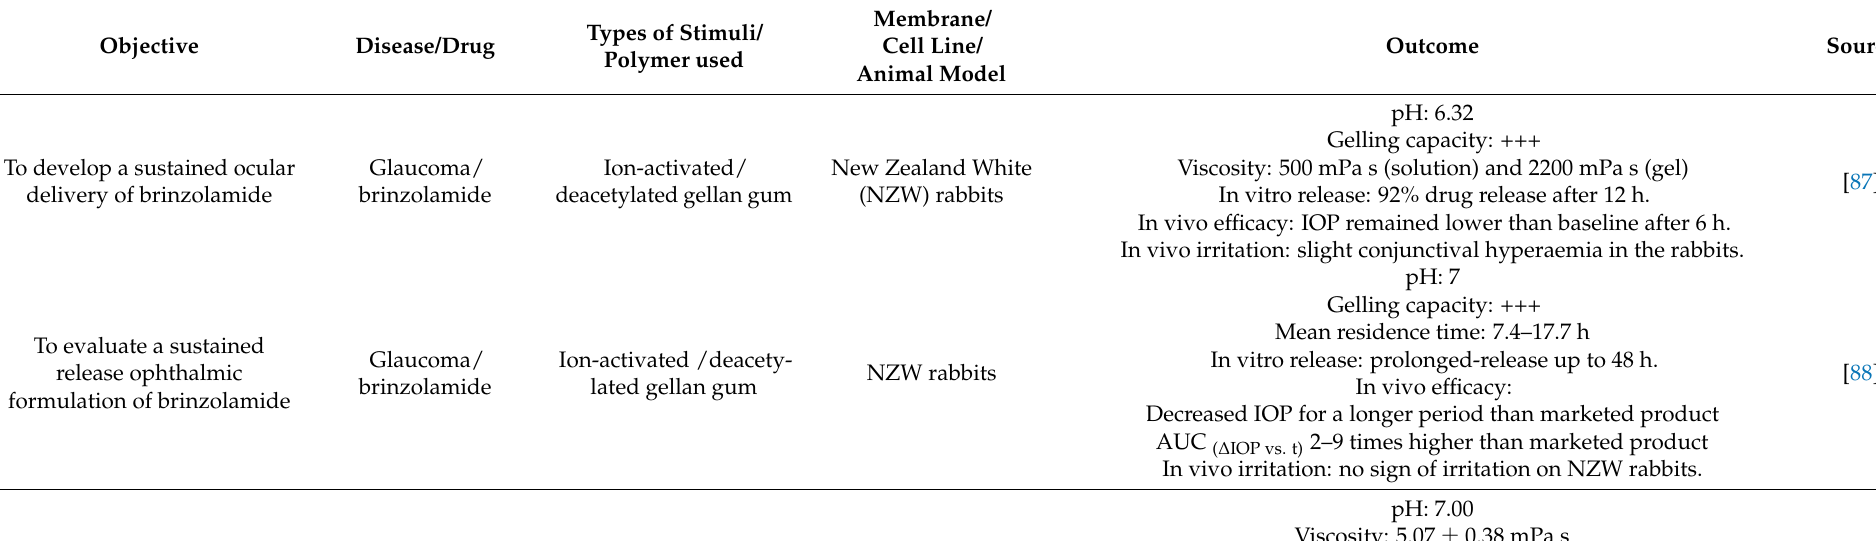
Table 3. Smart ocular delivery using ion-responsive in situ gel approach against ocular